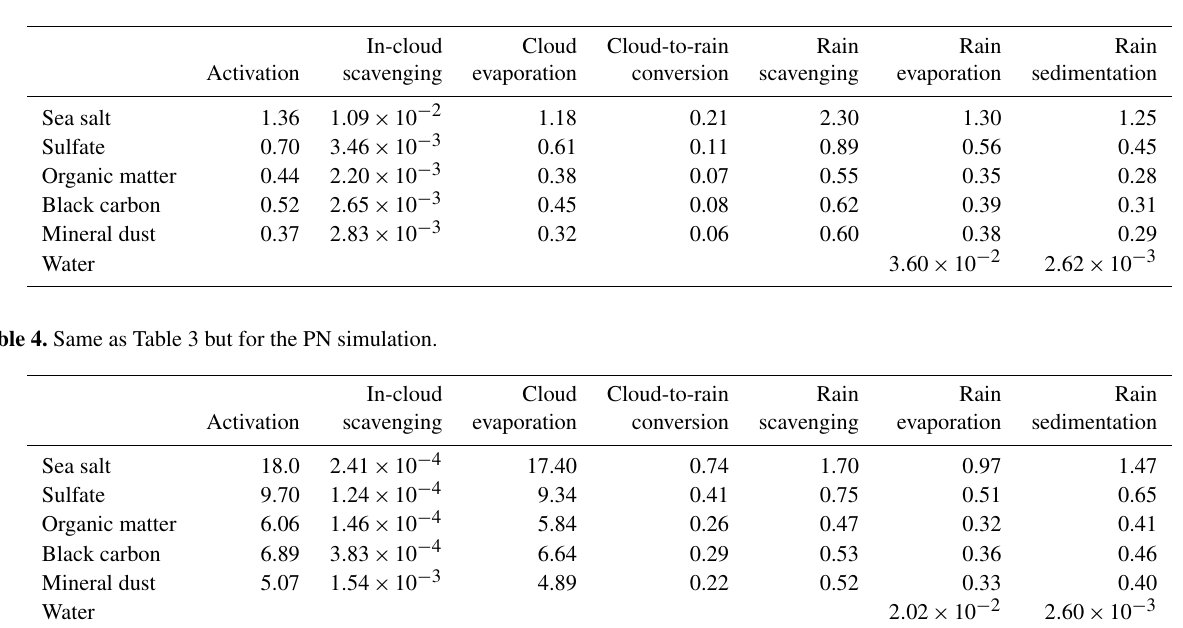
Table 3. Domain-averaged total column microphysical process strengths (kgkg − 1 d − 1 ) in the KAPPA simulation for the different aerosol species, divided by the species total column aerosol mass (kgkg − 1 ) and rescaled to have the unit per day (d − 1 ). Reported values can be thus interpreted as timescales, e.g. activation processes 1.36 times the total column sea salt aerosol mass per day.